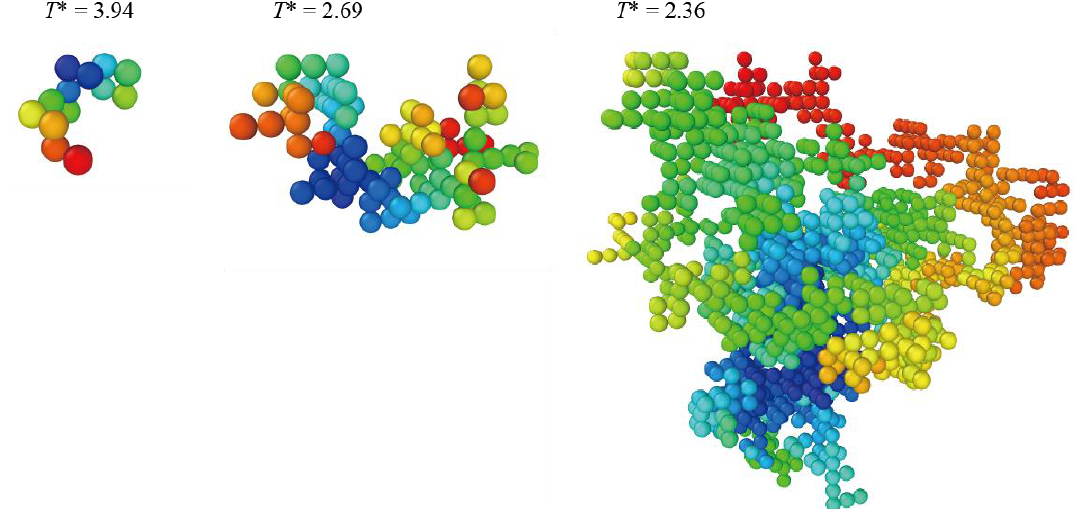
Figure 1. Examples of dynamically correlated networks (DCNs) generated via Monte Carlo simulation. The color of the segments varies gradually from blue to red in the order of being added to the network.